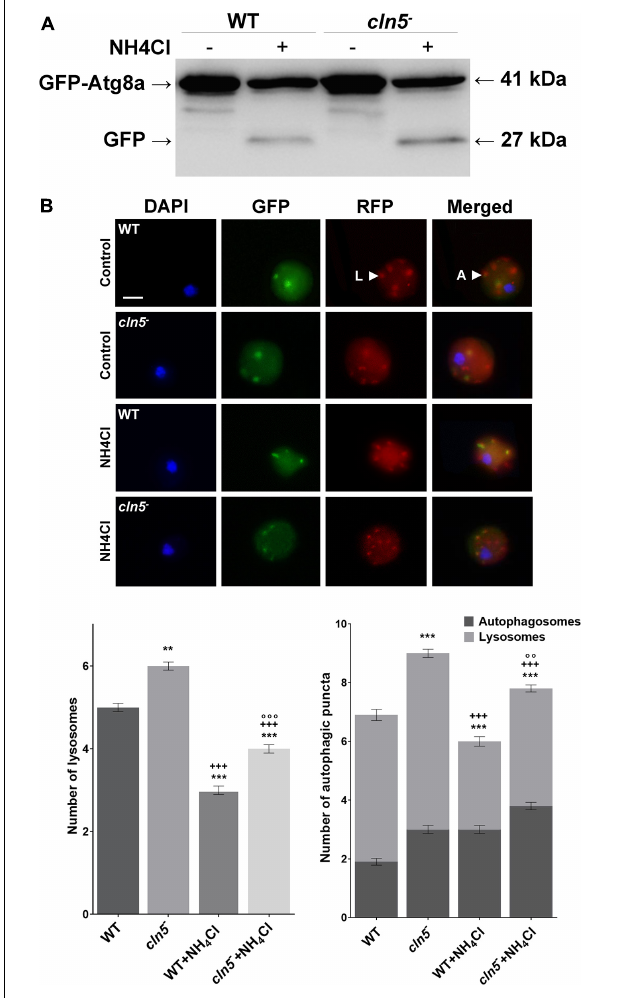
FIGURE 4 | GFP-Atg8a and RFP-GFP-Atg8a autophagic flux assays. (A) WT and cln5 − cells expressing GFP-Atg8a were submerged in HL5 ± ammonium chloride (150 mM) for 4 h. A pulse of ammonium chloride (150 mM) was added halfway through the incubation (after 2 h). Whole cell lysates (30 µ g) were separated by SDS-PAGE and analyzed by western blotting using anti-GFP. Molecular weight markers (in kDa) are shown to the right of the blot. Western blot is representative of three independent experiments. (B) WT and cln5 − cells were submerged in low fluorescence HL5 ± ammonium chloride (150 mM) for 4 h, with a pulse of ammonium chloride (150 mM) added halfway through the incubation (after 2 h). Cells were fixed and stained with DAPI to reveal nuclei (blue). Scale bar = 2.5 µ m. The average number of autophagosomes and lysosomes was quantified. Data presented as mean number of lysosomes ± SEM ( n = 3, at least 60 in total were analyzed) and mean total number of autophagic puncta ± SEM ( n = 3, at least 60 in total were analyzed). Statistical significance was assessed using the non-parametric Kruskal–Wallis test followed by Dunn’s multiple